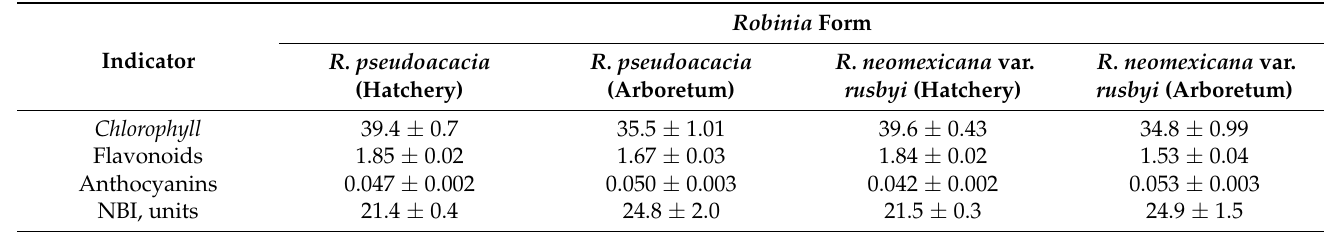
Table 4. The pigment system of R. pseudoacacia and R. neomexicana var. rusbyi in various cultivation conditions, mcg/cm 2 of raw mass.